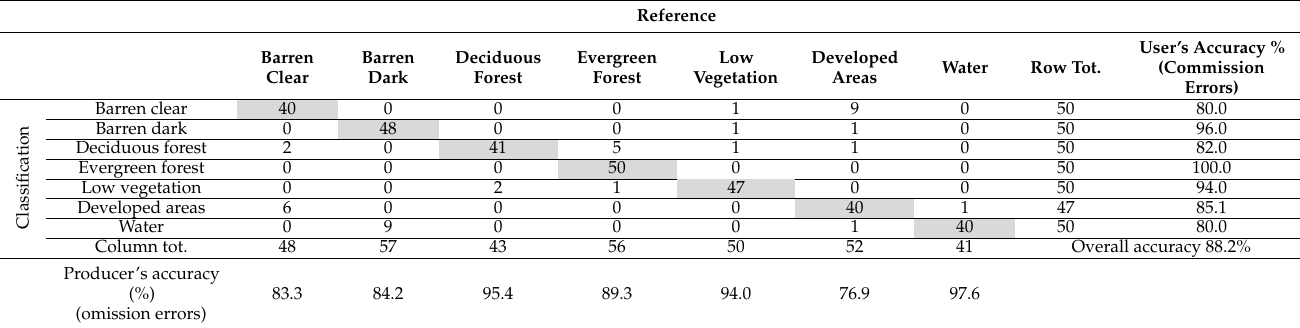
Table 4. The error matrix for the classification of 1996. Values in the cells represent the number of objects, while accuracies are reported with the percentage of land